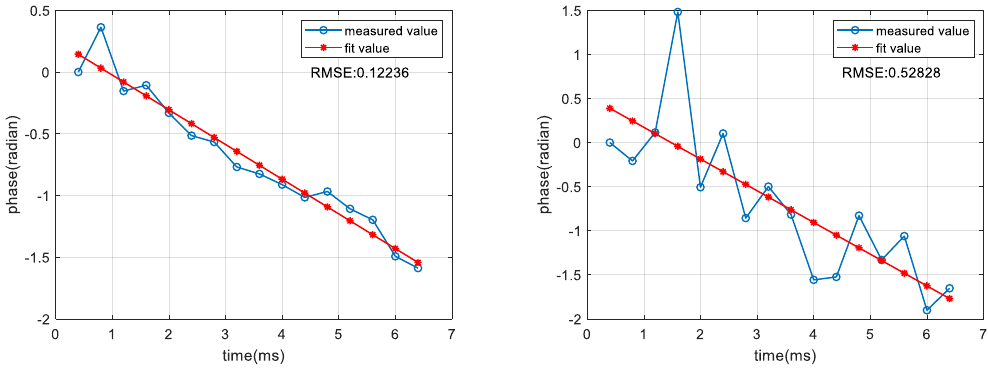
Figure 1. Observed and fitted values of ACF phase.